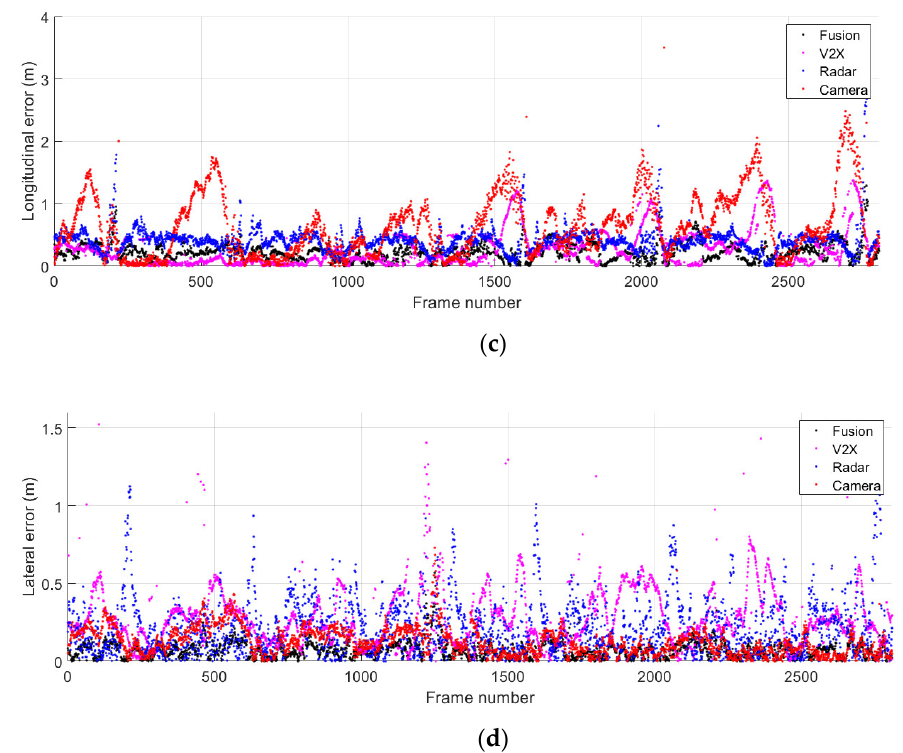
Figure 17. Relative distance to the remote vehicle during the cut-in driving scenario 3. ( a ) Ground truth longitudinal distance; ( b ) ground truth lateral distance; ( c ) absolute error for longitudinal distance estimates; ( d ) absolute error for lateral distance estimates.